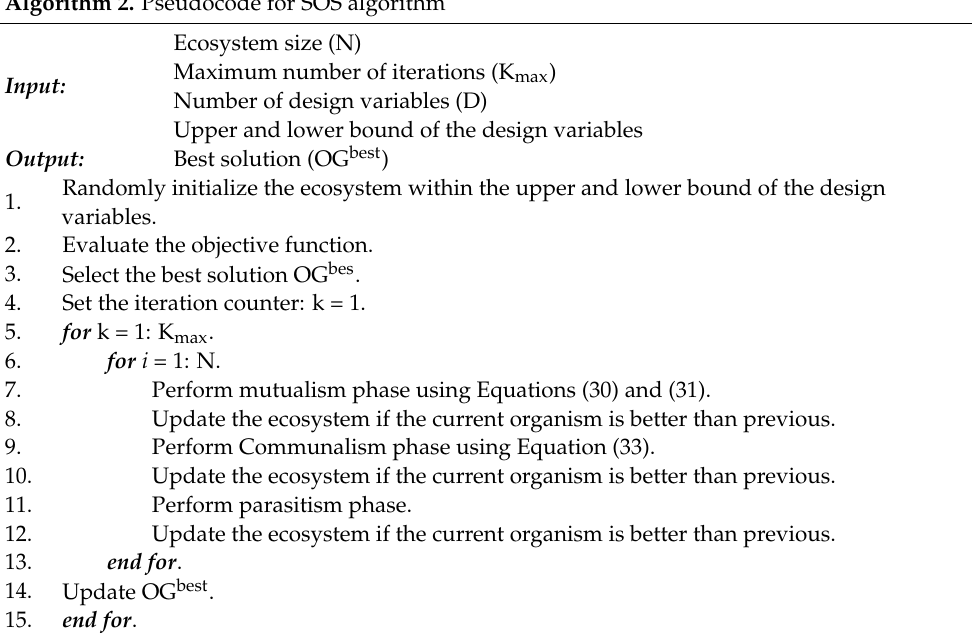
Algorithm 2. Pseudocode for SOS